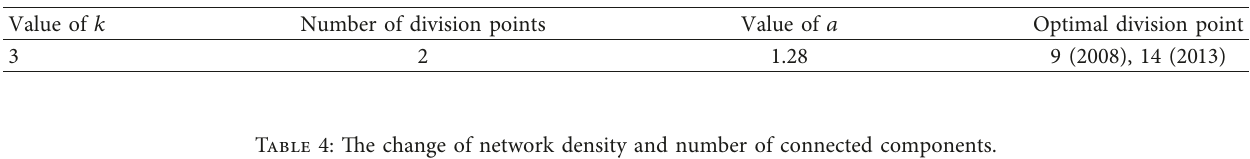
Table 3: Results of network segmentation.